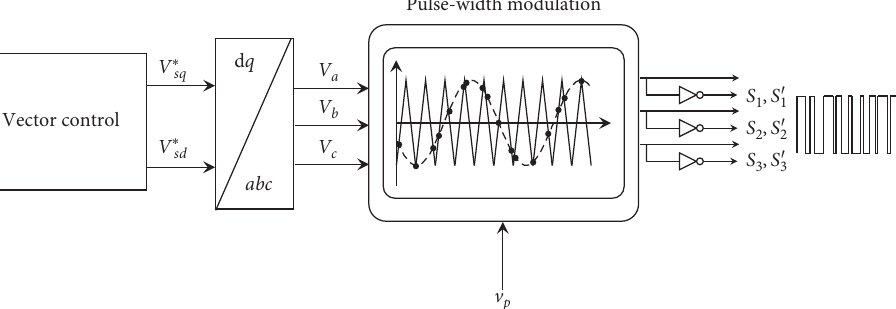
Figure 3: Induction machine